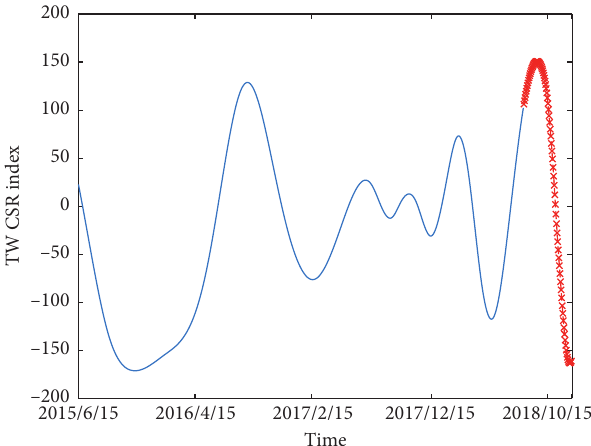
Figure 18: LSTM prediction results for IMF5.